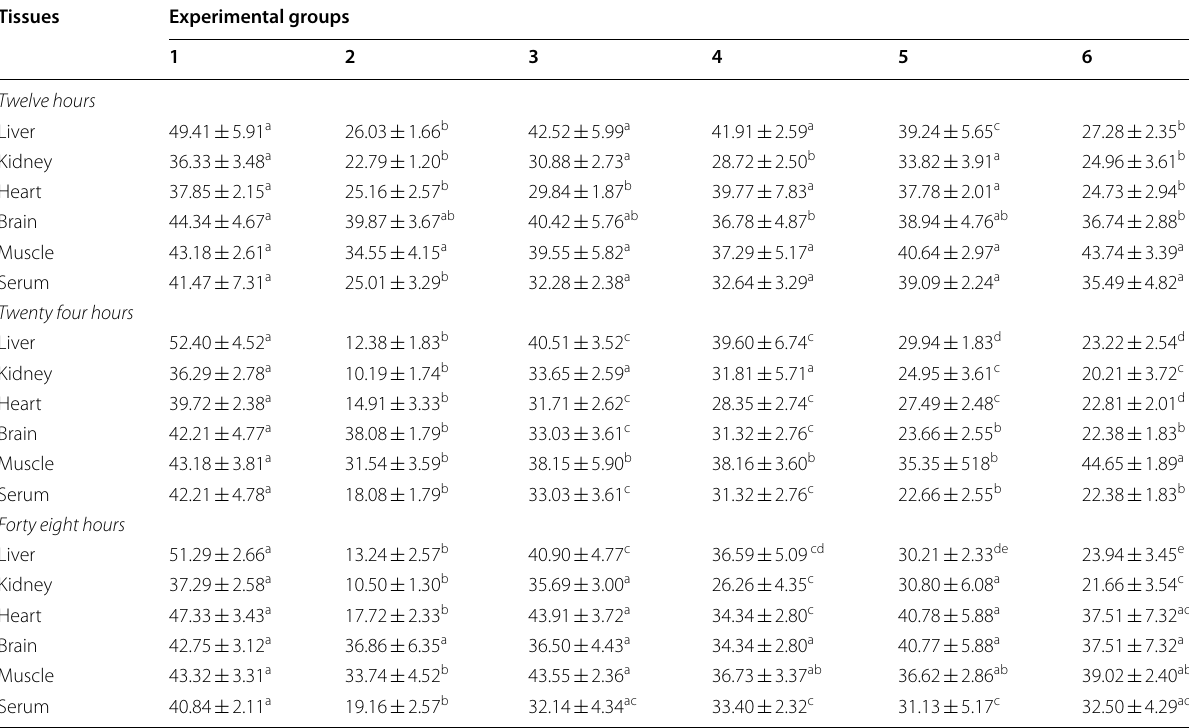
Table 3 Effect of palm oil fractions on activities of tissue and serum catalase (CAT) of rats administered